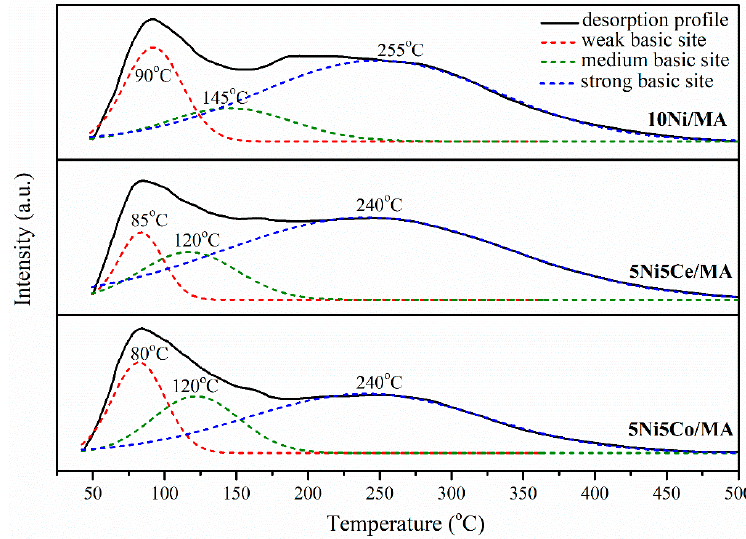
Figure 5. CO 2 -TPD profile of catalysts.